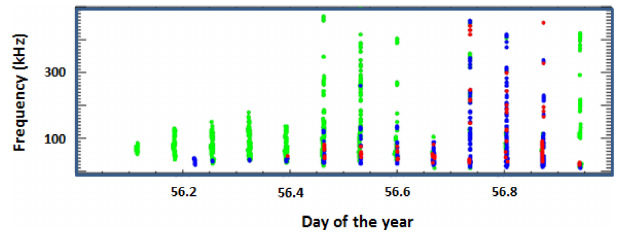
Figure 4. Vertical lines indicate the occurrence of the frequency- banded emissions observed on 25 February 2010. Those events were recorded on the night side of Earth with a time inter- val of about 1h 35min. Green, blue and red specify, respec- tively, three power level intervals, i.e. 10 − 3 –0.7, 0.7–10 and 10– 10 + 4 µVm − 1 Hz − 1 / 2